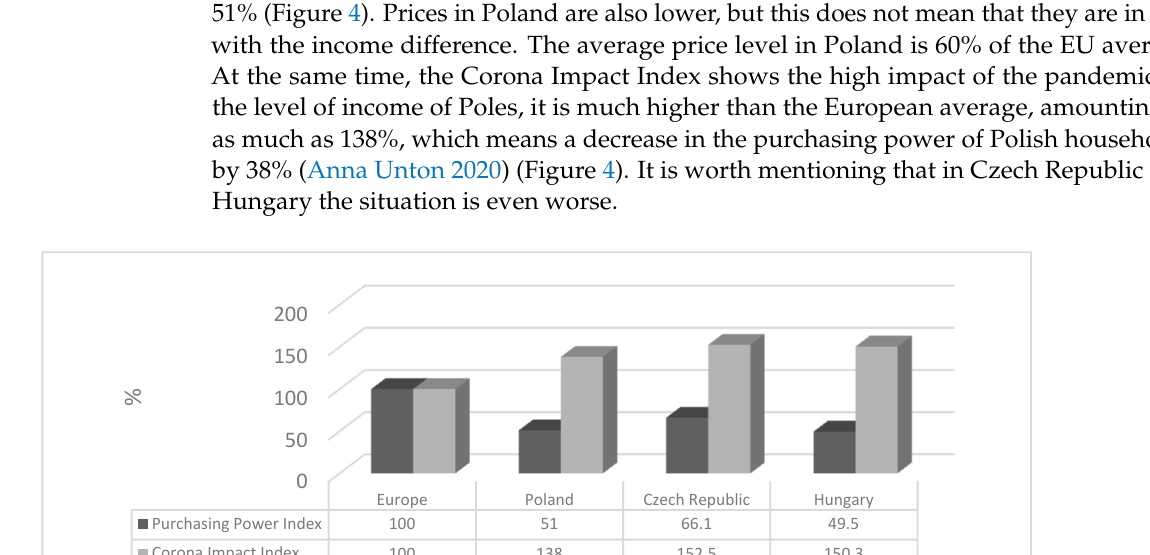
Figure 3. Household real gross disposable income (per capita) growth rate compared to previous quarter. Lack of sufficient data for Slovakia. Source: (OECD Database 2021).